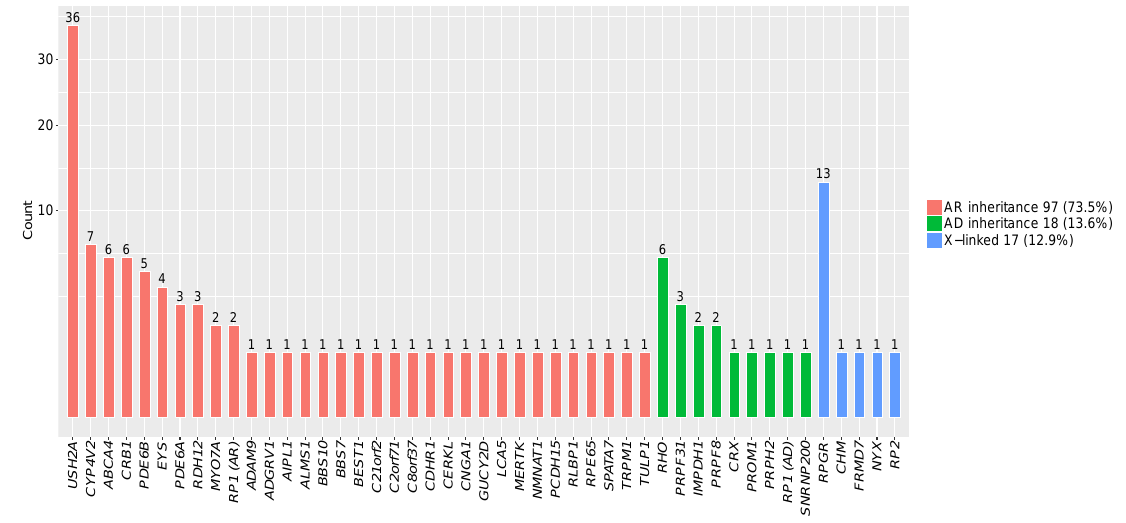
Figure 1. Genes with pathogenic or likely pathogenic mutations identified in 132 inherited retinal dystrophy (IRD) families which were genetically diagnosed. The percentage of inheritance patterns identified in this study. Prevalence of mutations in genes causing autosomal dominant (AD) IRD, autosomal recessive (AR) IRD and X-linked